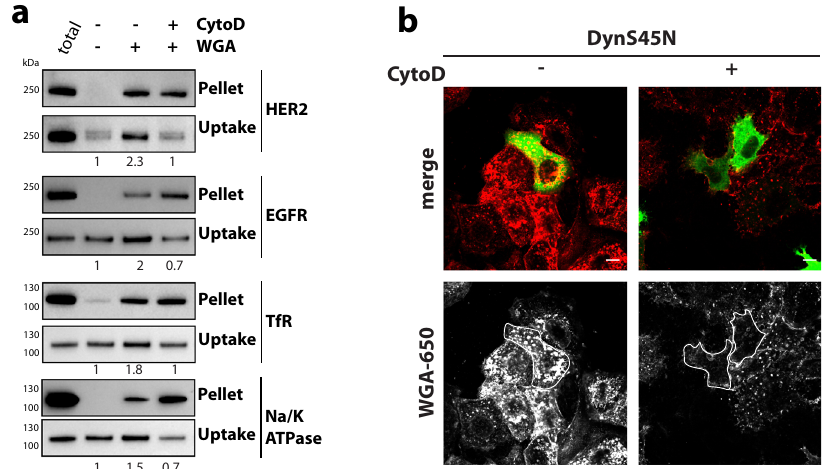
Fig. 5 | Aggregation-dependent endocytosis is induced by cross-linking mole- cules.a WGAaggregatesandinducesendocytosisofglycosylatedproteinsincells. After surface biotinylation, SkBr3 cells± CytochalasinD (CytoD) were incubated with WGA for 10min, and remaining surface biotin was removed. Samples were harvested after processing, as described in the “ Methods ” section, assayed by immunoblotforreceptortyrosine-proteinkinaseerbB-2(HER2),epidermalgrowth factor receptor (EGFR), sodium/potassium-transporting ATPase Alpha1 (Na/K-